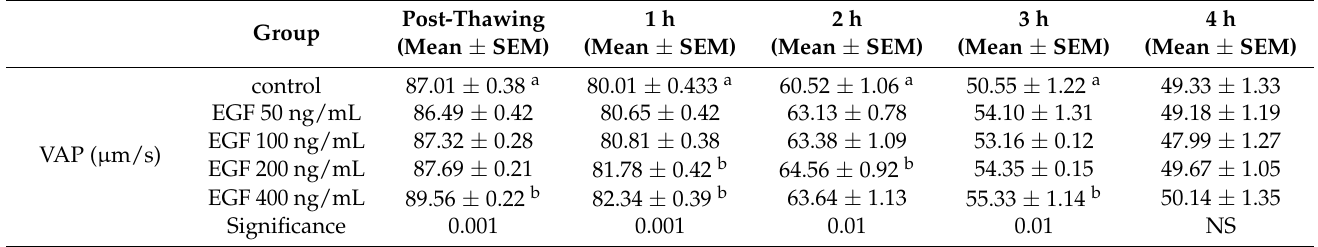
Table 3. Differences in velocity parameters between thawed semen extended with epidermal growth factor (EGF) at different concentrations (50, 100, 200, and 400 ng/mL) and controls (without EGF) at different post-thaw times (n = 8